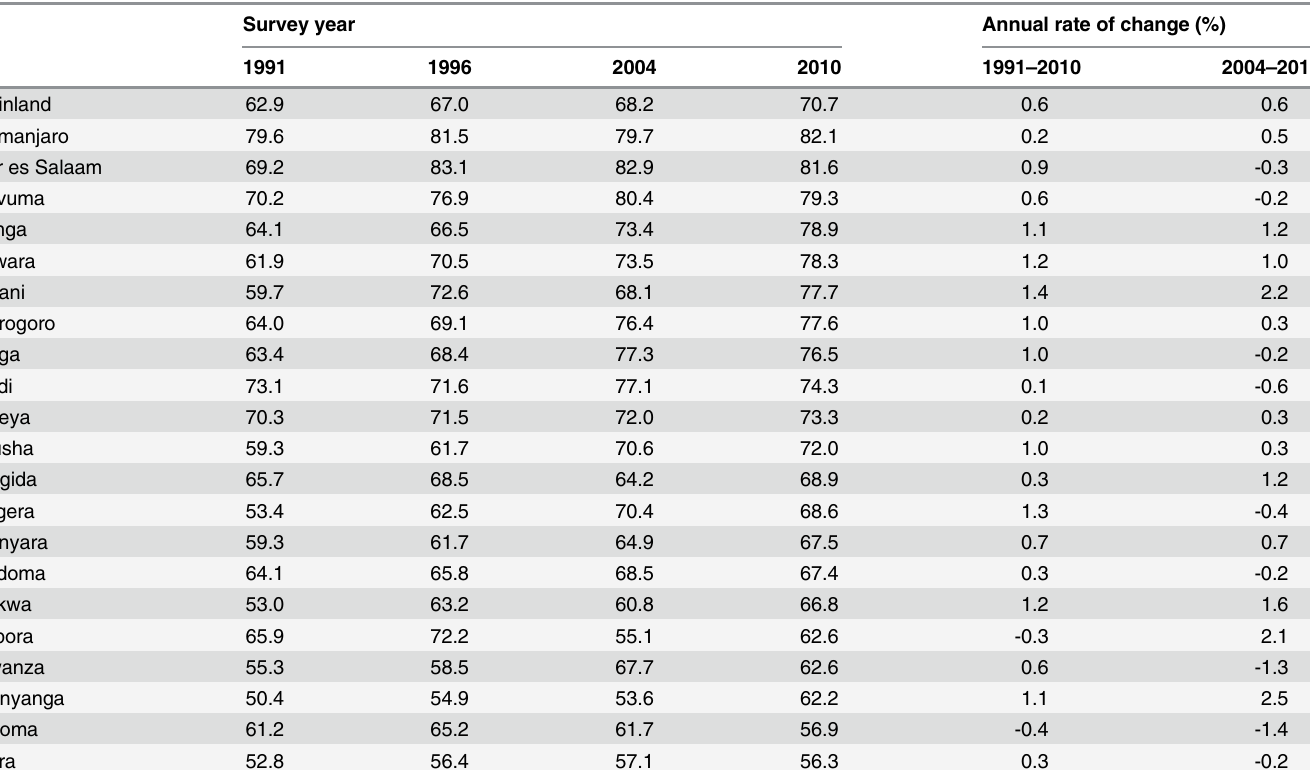
Table 3. Regional trends in the Countdown maternal, newborn and child health coverage score (%), based on demographic and health survey data 1991 – 2010, with average annual rate of relative change of the coverage rate during the whole period (1991 – 2010) and between the last two sur- veys (2004 –